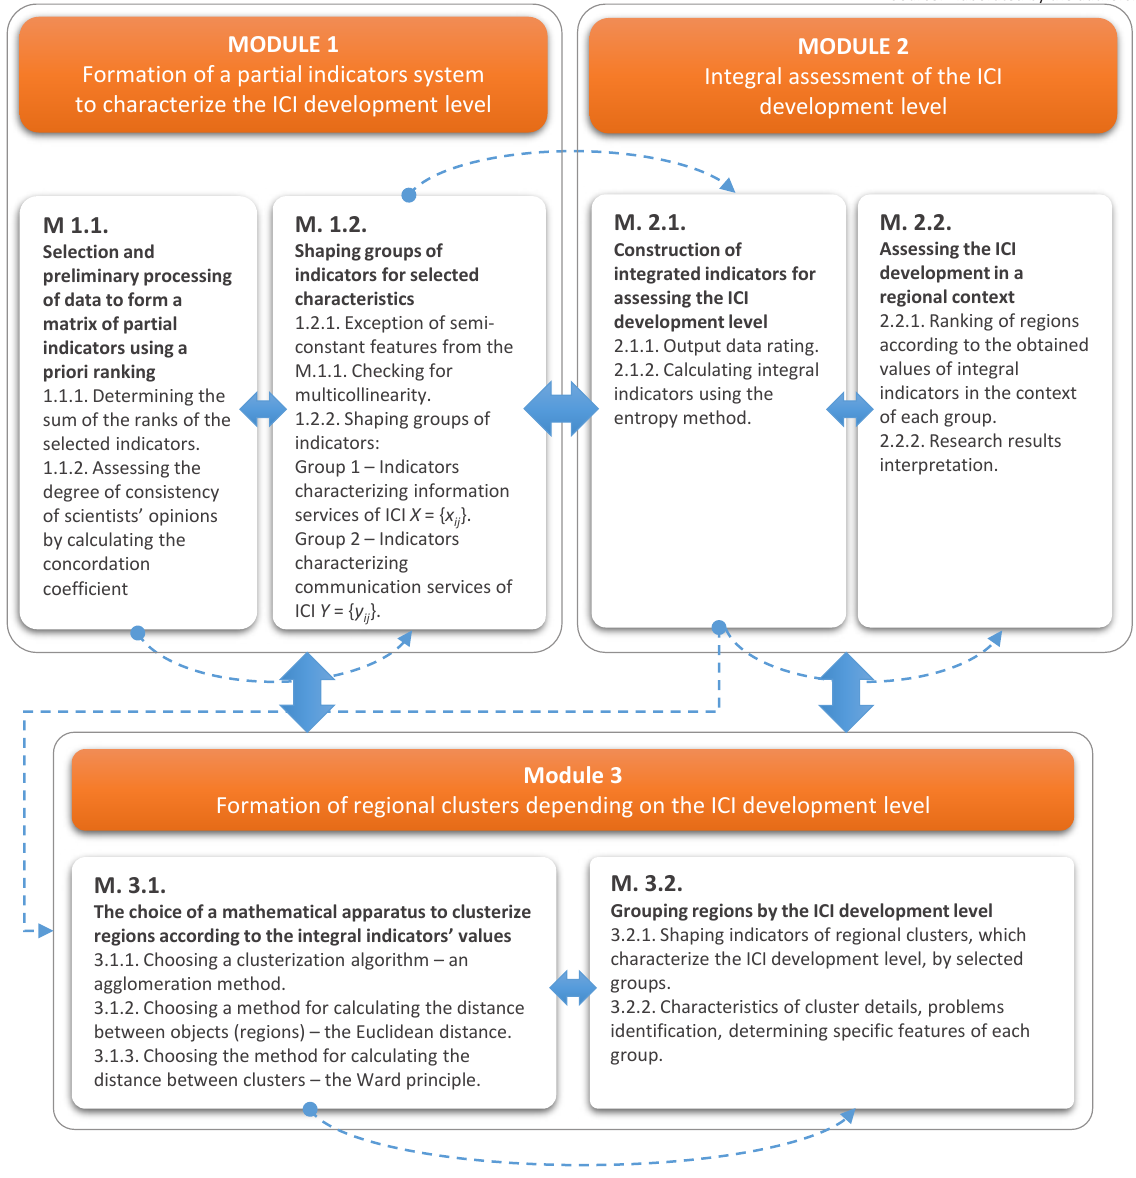
Figure 2. Scheme for the estimating the ICI development level in terms of